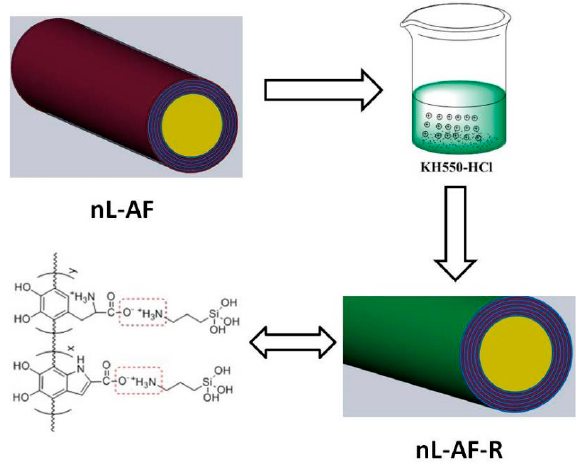
Figure 1. The schematic diagram of layer-by-layer self-assembly of L -PDOPA for surface modification of aramid fibers and electrostatic adsorption acidification of silane coupling agents (KH550).